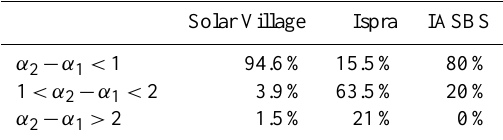
Table 3. Abundance of α 2 − α 1 calculated values for Solar Village, Ispra (Kaskaoutis et al., 2007), and